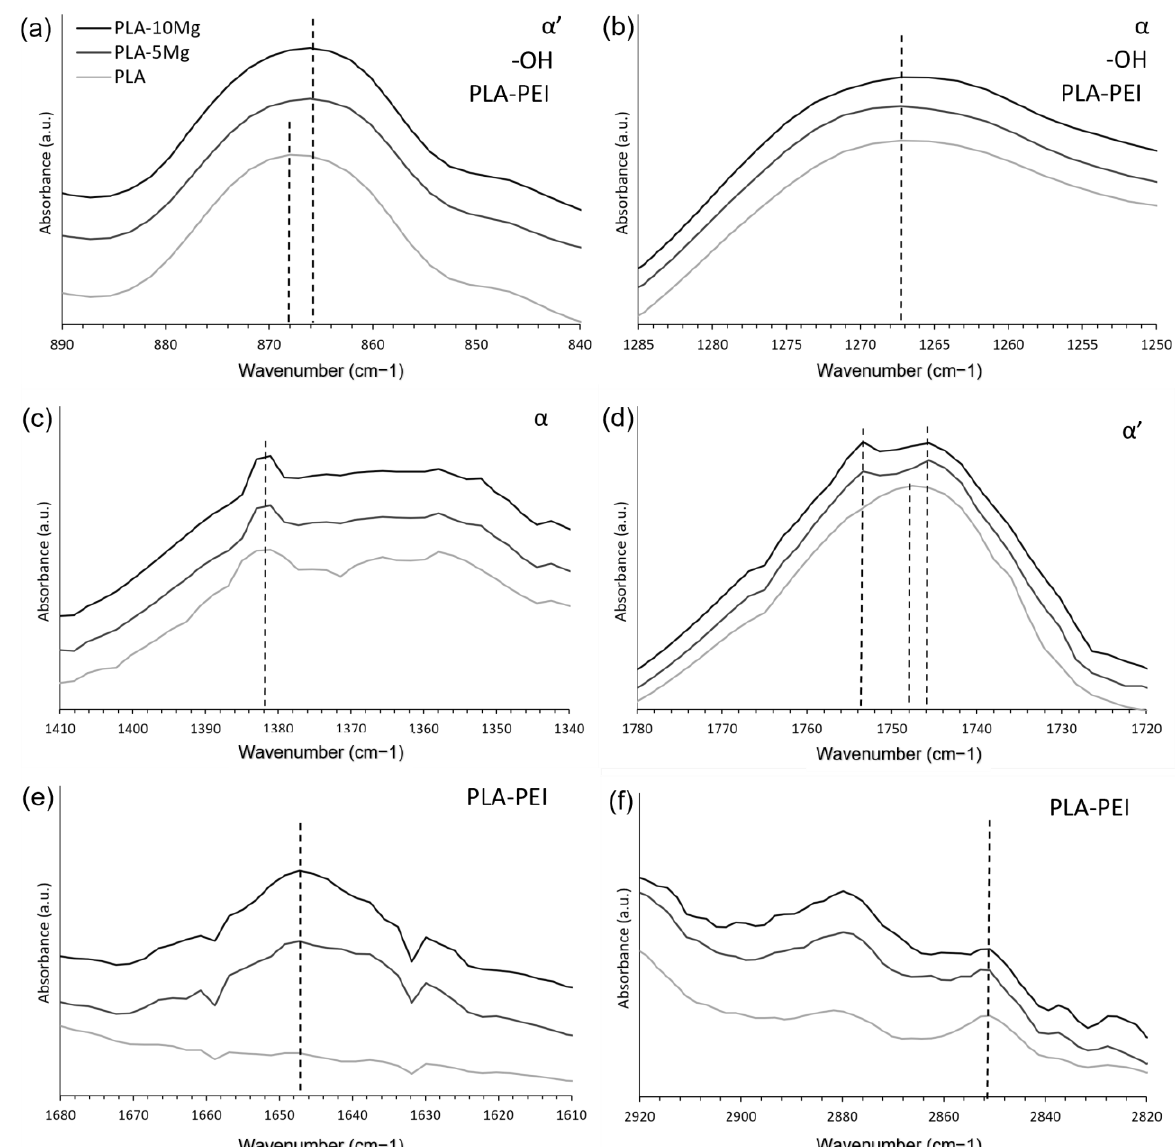
Figure 7. Details of FTIR of neat PLA and PLA-Mg composites, used to study α and α′ forms related peaks, -OH terminal groups, and PLA-PEI interactions. The studied effects related to that peak are shown in the upper right corner of each FTIR. (a) 868 and 866 cm −1 , (b) 1266 cm −1 , (c) 1382 cm −1 , (d) 1746, 1748 and 1754 cm −1 , (e) 1647 cm −1 and (f) 2850 cm −1 .